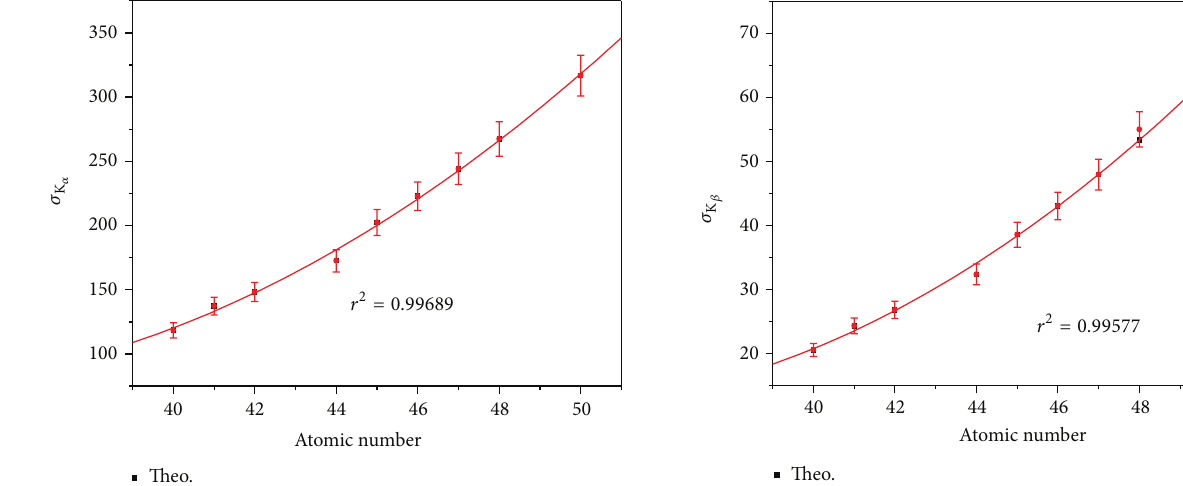
production cross sections as a K 𝛼